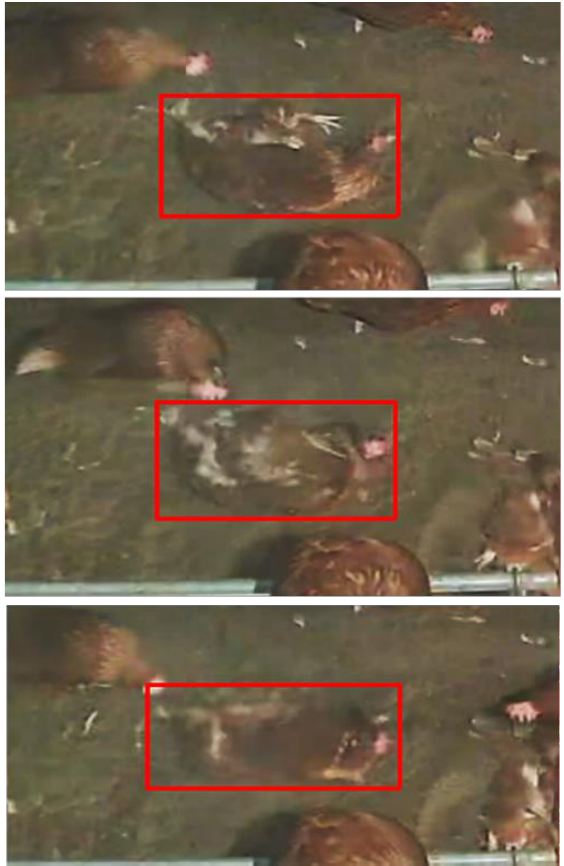
Figure 1. A dust-bathing hen (in red boxes) in three consecutive frames, as labelled for the training of the model.